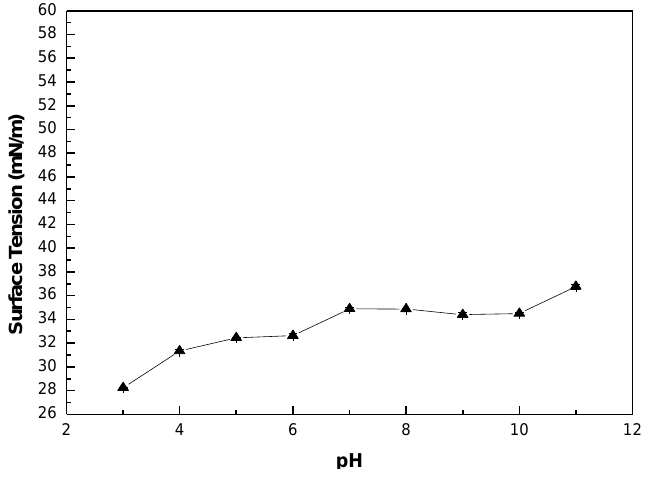
Figure 6. Effect of pH on surface tension of biosurfactant solution. (Biosurfactant): 300 mg/L.